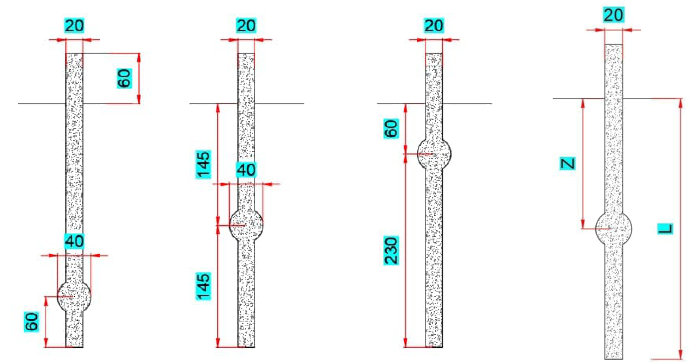
Figure 3: Sketch of single bulb under-reamed piles with different bulb